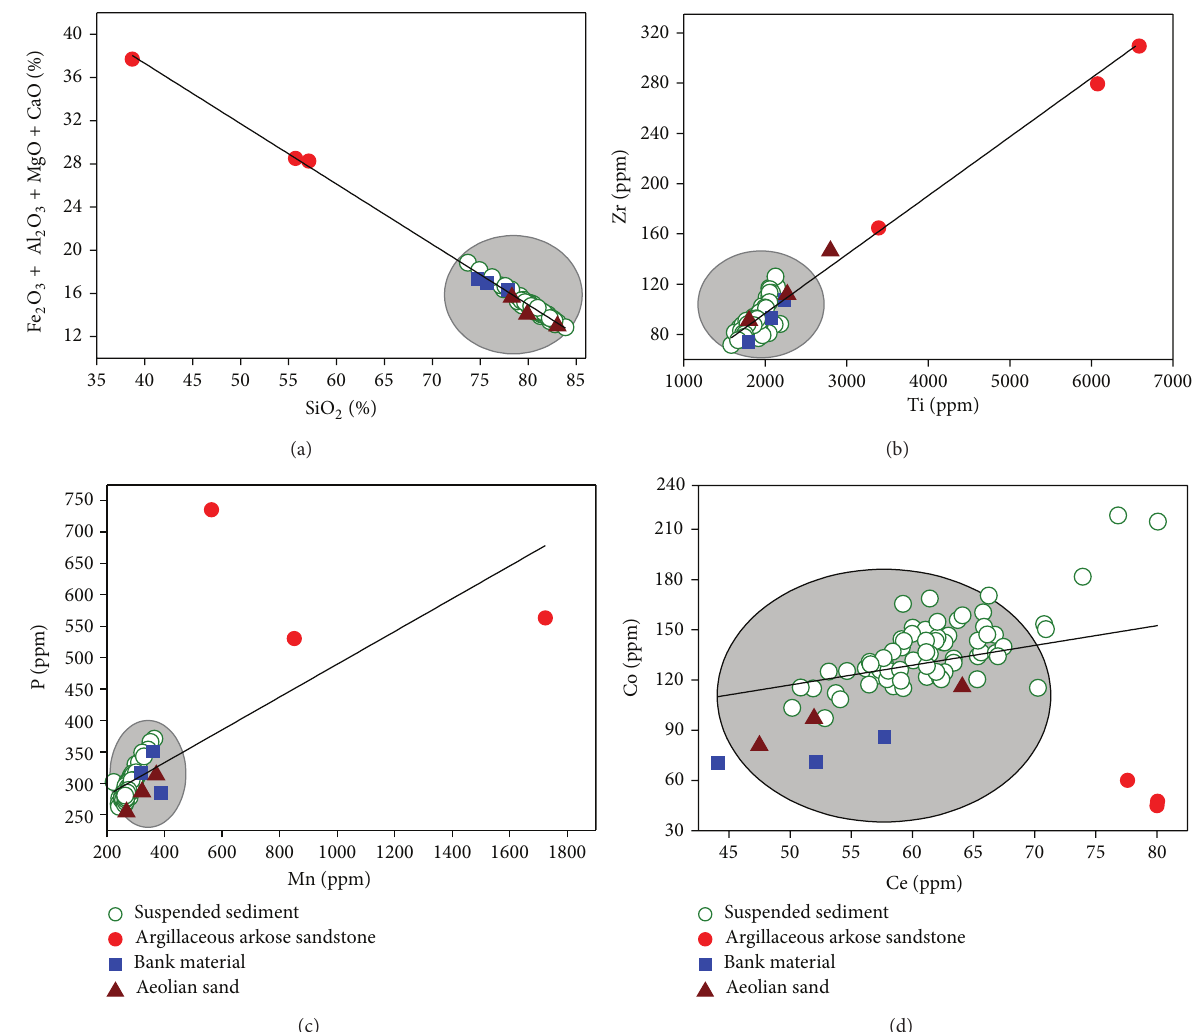
Figure 5: Scatter plots of some elements in samples collected in the Sudalaer